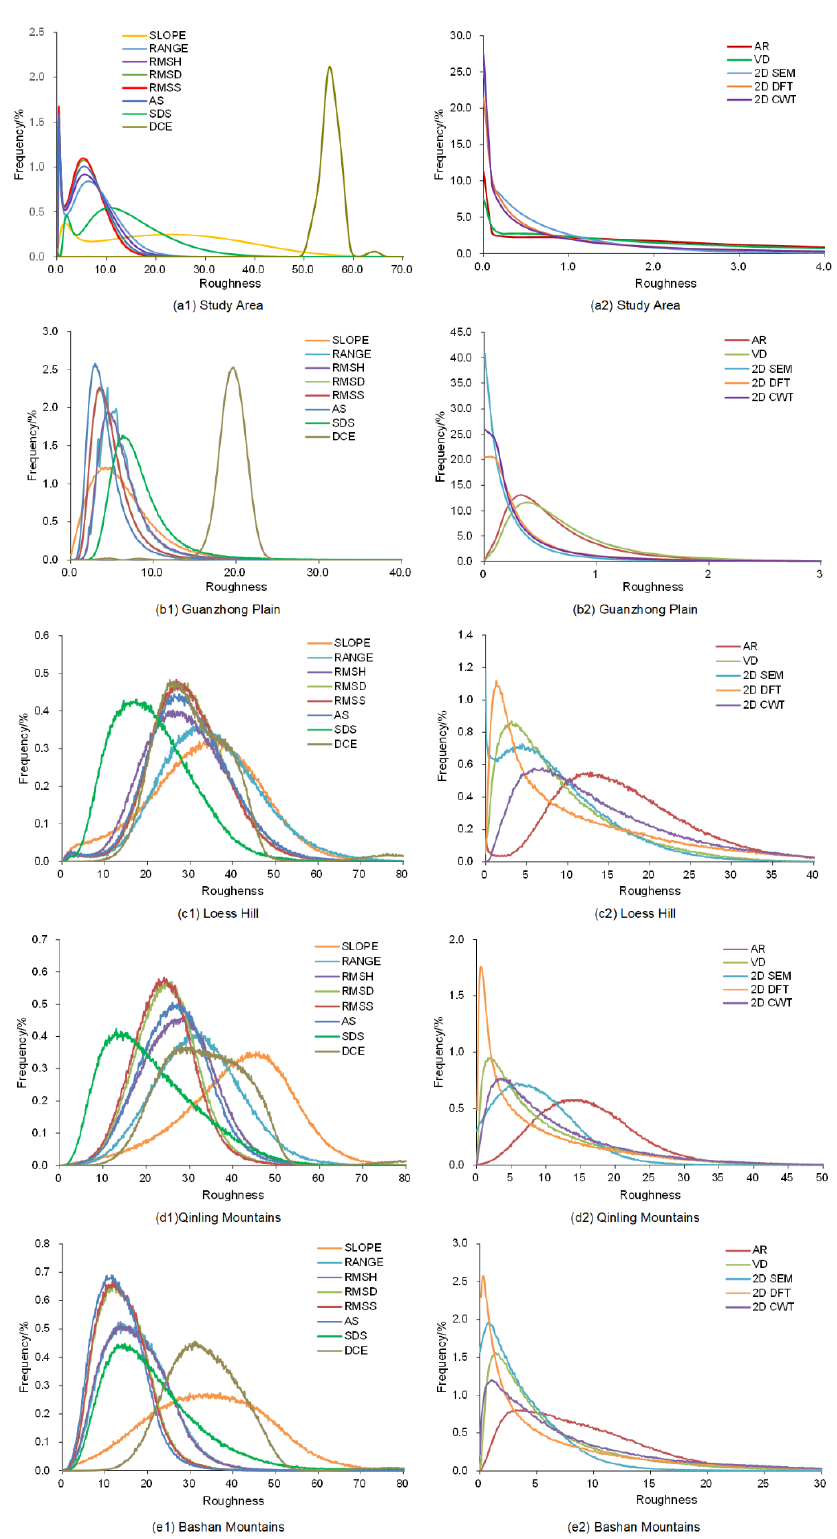
Figure 6. ( a ) Frequency curves of different roughness algorithms of whole study area; ( b ) Frequency curves of different roughness algorithms of Guanzhong plain sample area; ( c ) Frequency curves of different roughness algorithms of loess hill sample area; ( d ) Frequency curves of different roughness algorithms of Qinling mountains sample area; ( e ) Frequency curves of different roughness algorithms of Bashan mountains sample area.